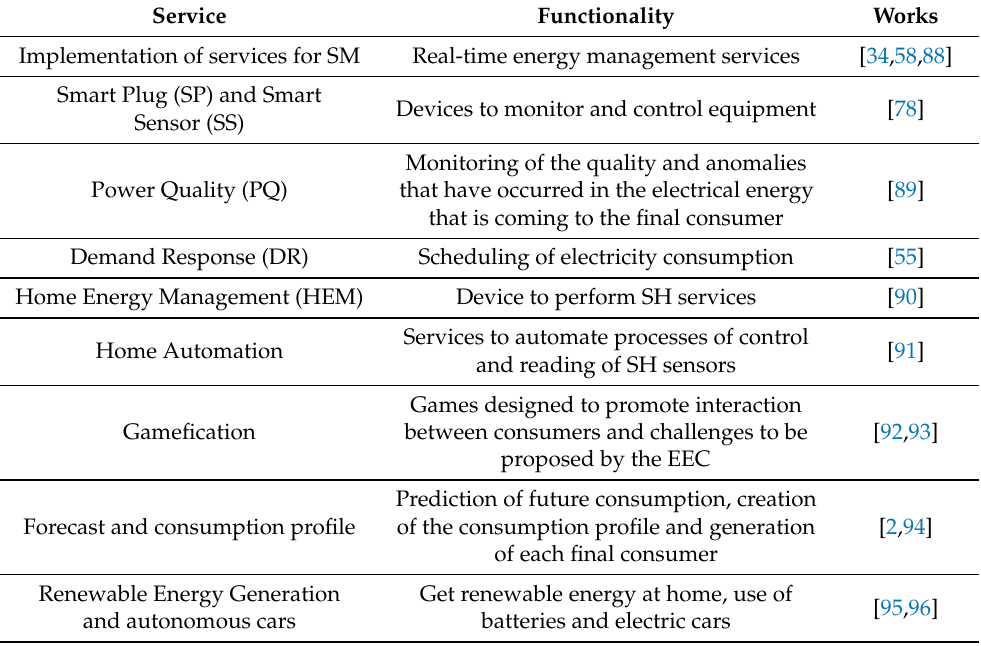
Table 1. DSM services proposed by the current state of the